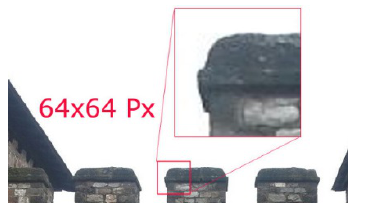
Figure 3. 64x64 pixel patch (1600x1200px), (Kampa et. al., 2014)